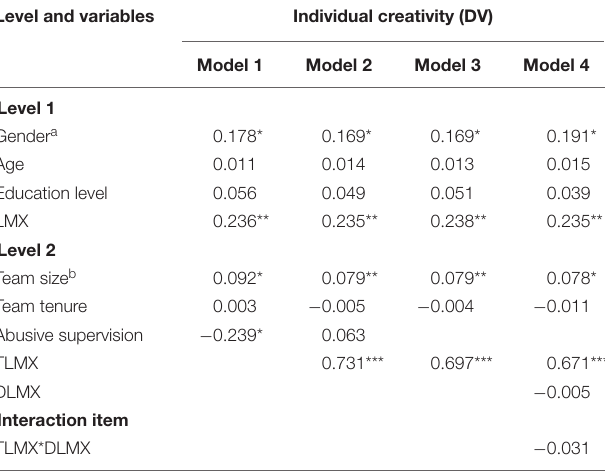
TABLE 4 | HLM results for cross-level analysis.